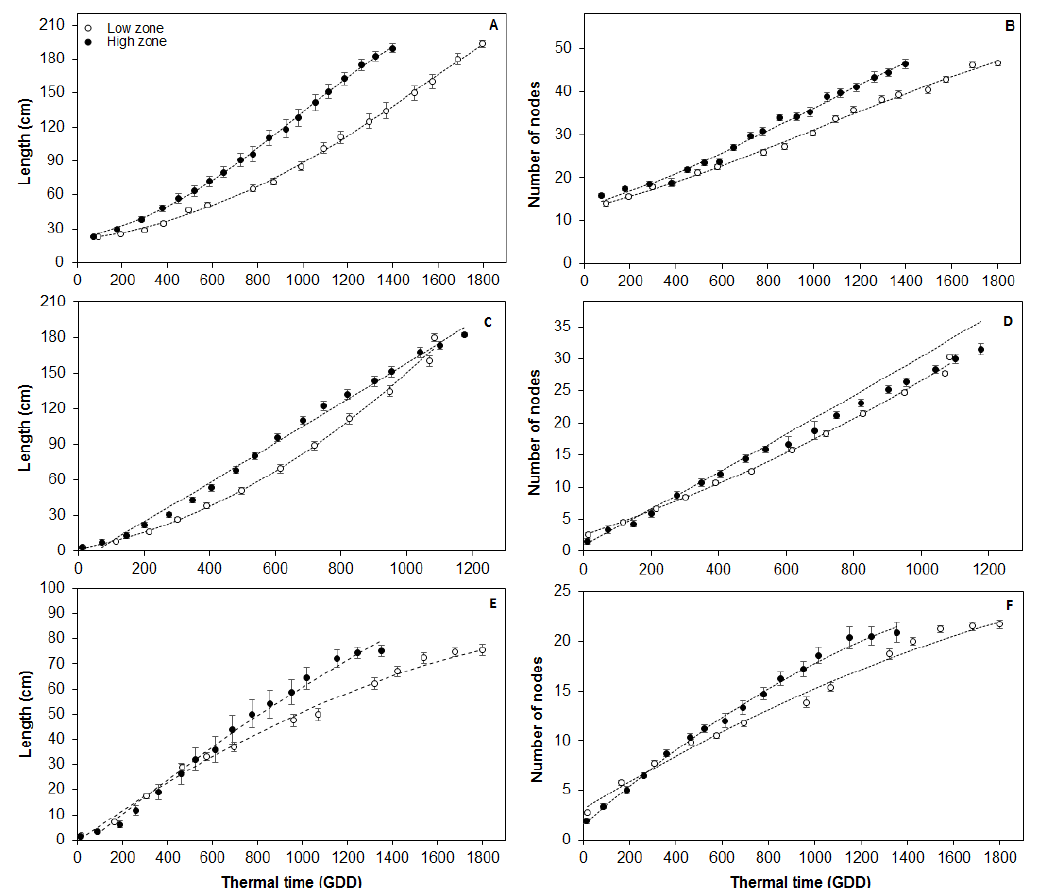
Fig. 2: Node length, growth and development of node number as a function of thermal time in the main stem (A and B), primary branches (C and D) and secondary branches (E and F) of P. tripartita var. mollissima in a high zone (2,498 m.a.s.l.) and a low zone (2,006 m.a.s.l.) in the municipality of Pasca (Cundinamarca, Colombia). Vertical bars indicate the standard error (n = 15).